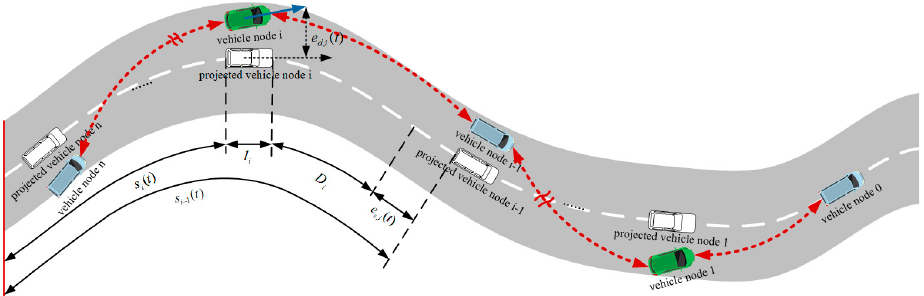
Figure 3. Coordinate system conversion diagram.